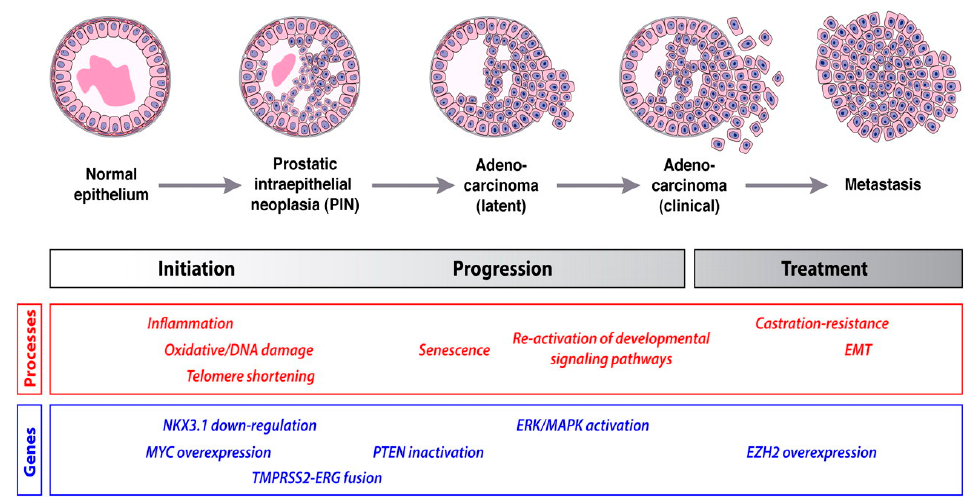
Figure 1. A schematic depicting the development of prostate cancer. The stages of the cancer onset and progression are indicated by the molecular processes, genes, and signaling pathways which are important in different stages of cancer. The first sign of prostate cancer is an inflammation of the mutations that arise due to damaged DNA. At a chromosomal level, the initiation of prostate cancer begins with the shortening of telomerase at the end of the chromosome. Oxidative stress from prostate shown the impact of the gene on the prostate cancer initiation phase in mice. No tumor suppressor